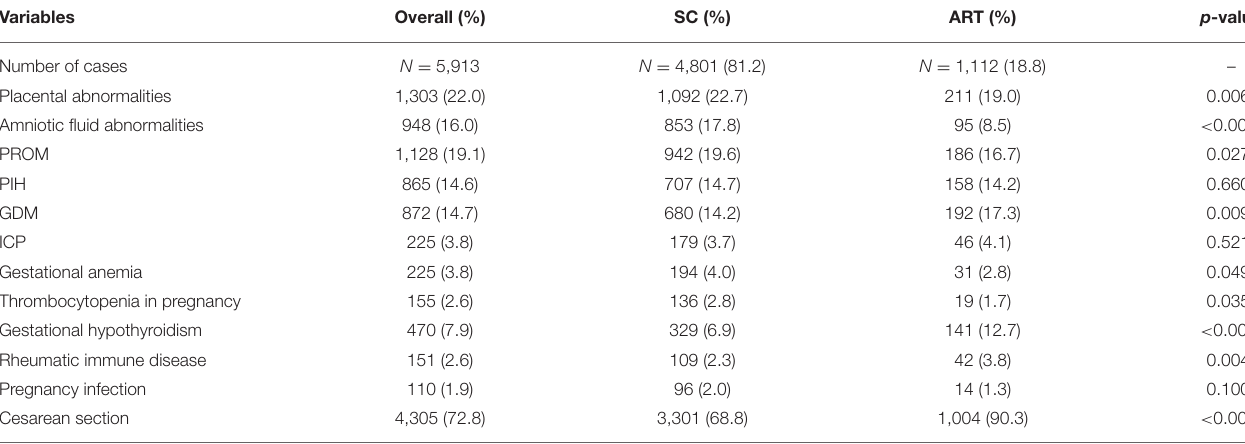
TABLE 2 | Maternal pregnancy complications between the SC and ART groups.